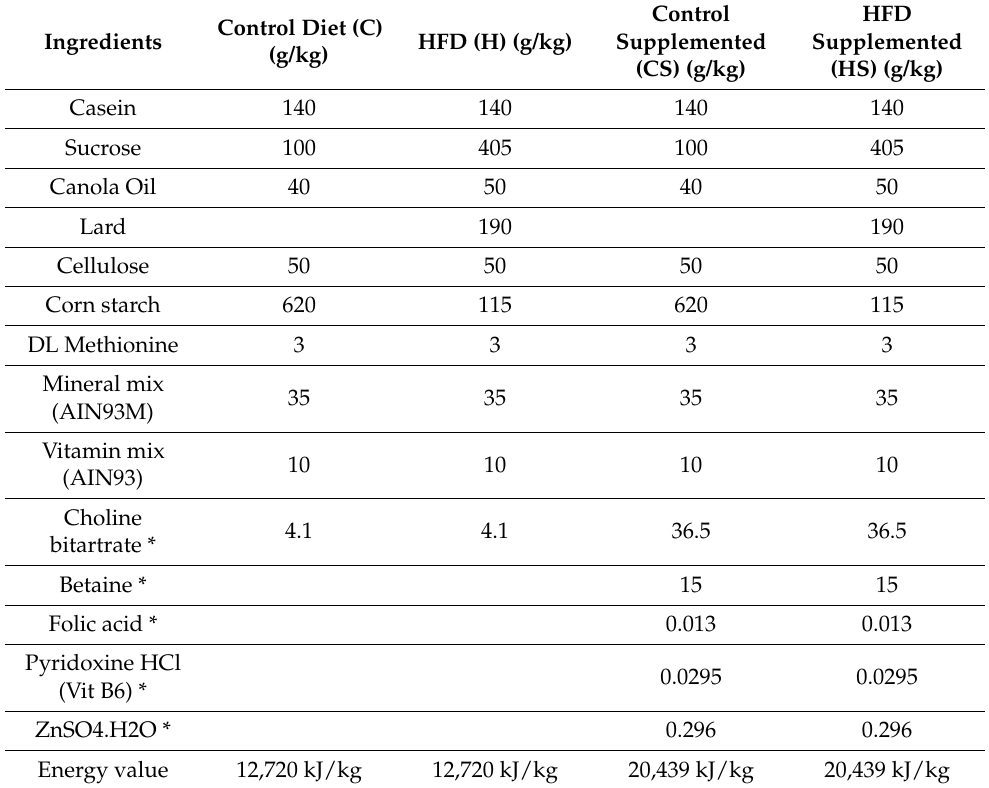
Table 1. Chemical composition per kilogram of C, H, CS and HS diets. The supplemented diets had additional Choline, Betaine, Folic acid, Vitamin B6 and